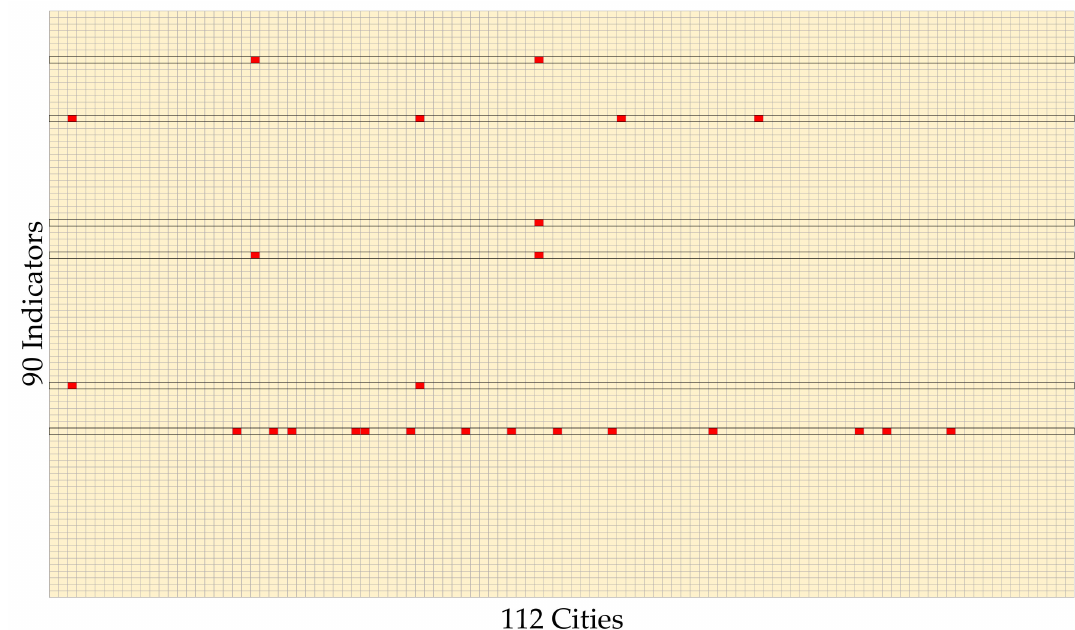
Figure 3. Missingness map showing the 26 missing values for 6